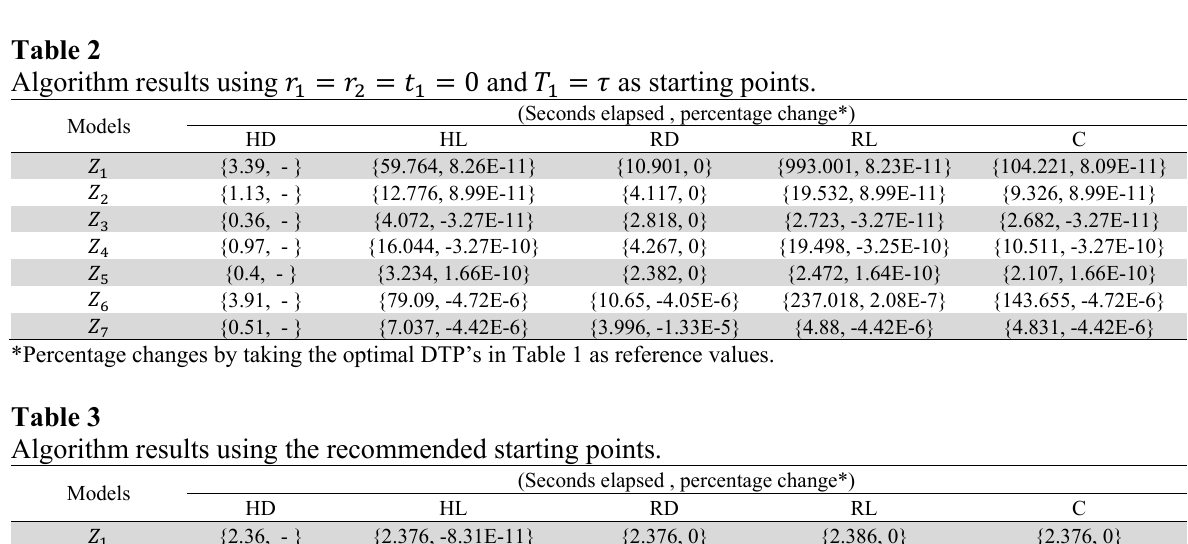
(cid:3404) (cid:2028) as starting points. (cid:2869)